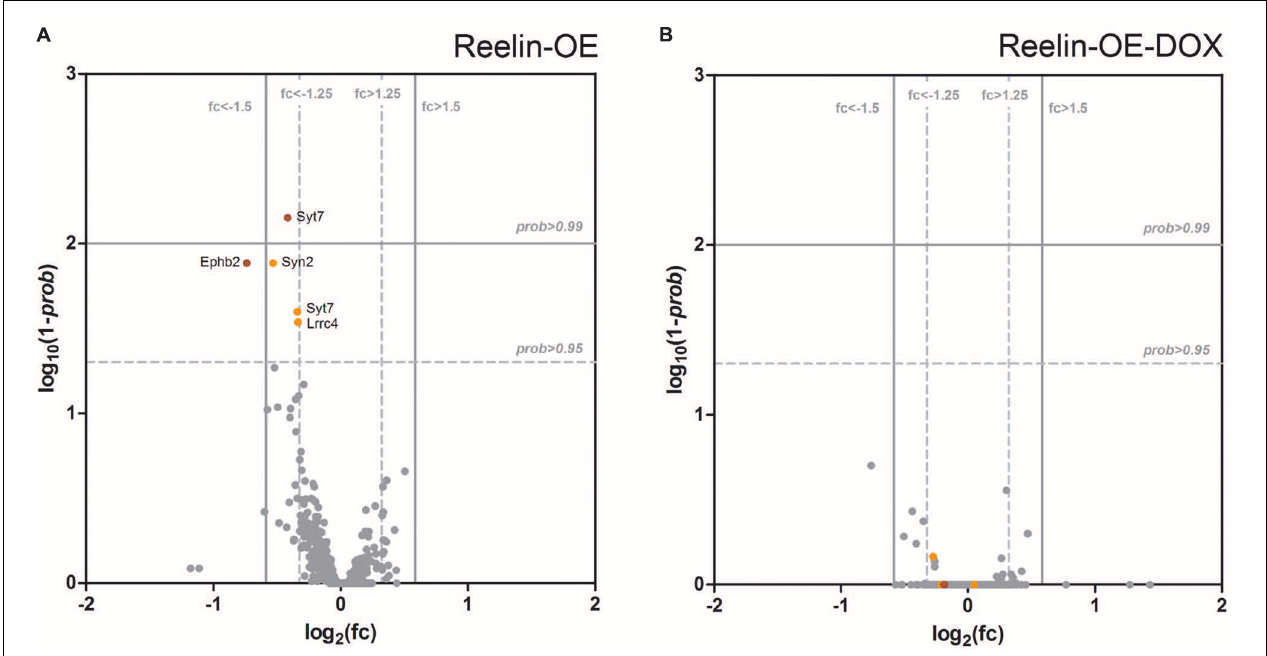
FIGURE 6 | Analysis of differential expression of genes directly associated with “Synapse” (GO:0045202) in the hippocampus of Reelin-OE mice. (A,B) Volcano plots showing the magnitude of differential gene expression compared with control mice. Each dot represents an independent probe for a GO:0045202 gene. The vertical and horizontal lines mark the thresholds for defining up-/down-regulation for probability ( prob ) and fold change (fc), respectively. (A) Reelin-OE mice show most of the probes with non-differential expression (gray dots). Five probes show down-regulation (orange/red dots). (B) Reelin-OE mice treated for 1 week with doxycycline (Reelin-OE-DOX) do not show differences in gene expression with control